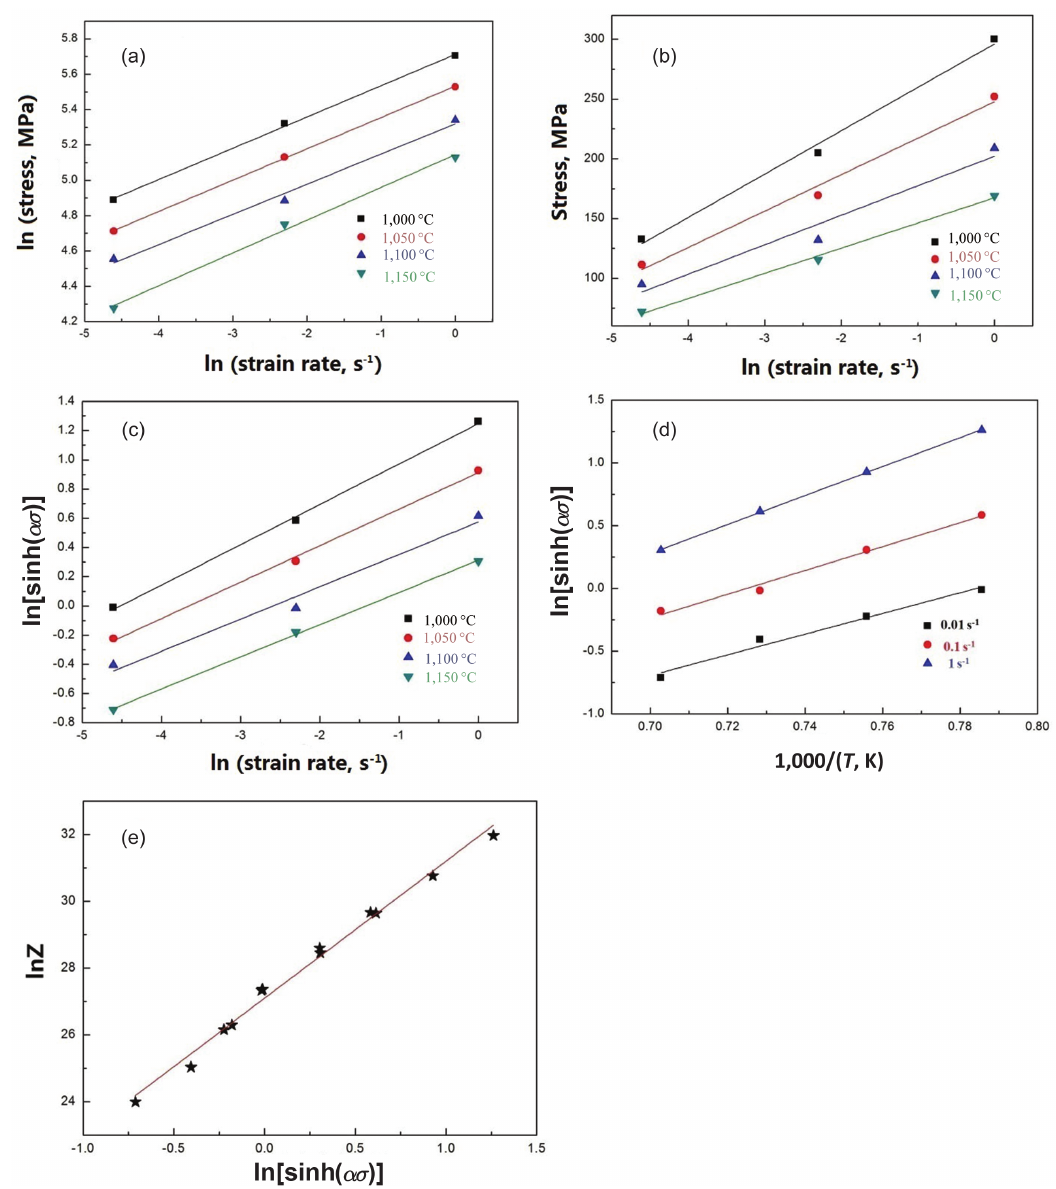
. − ln ½ sinh ð ασ Þ(cid:2) ; (d) ln ½ sinh ð ασ Þ(cid:2) − (10 3 / T ); and (e) ln Z − ln ½ sinh ð ασ Þ(cid:2)